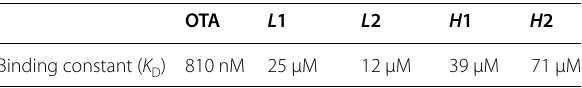
) of OTA and switching peptides ( L 1, D